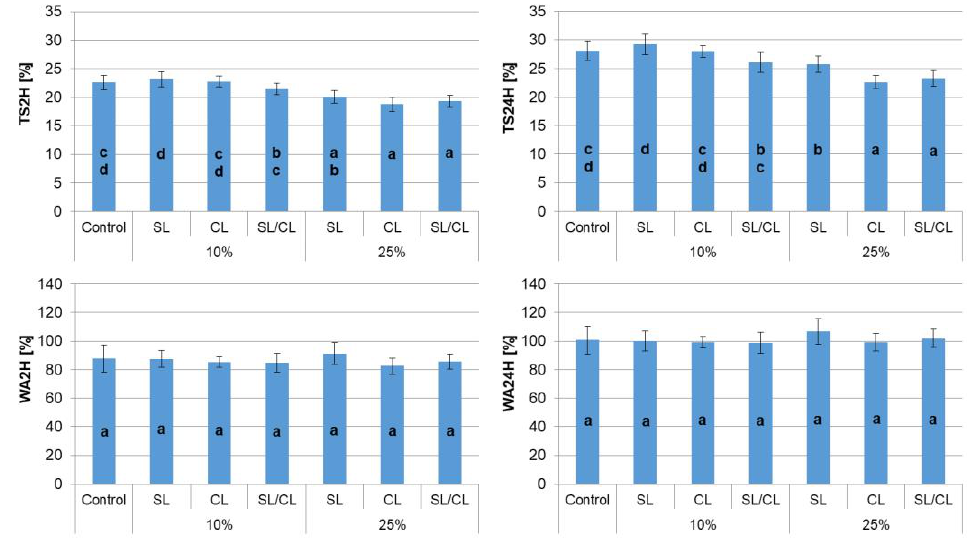
Figure 7. Thickness swelling and water absorption after 2 and 24 h of soaking in water. a,b,c,d — homogenous group by Tukey test.